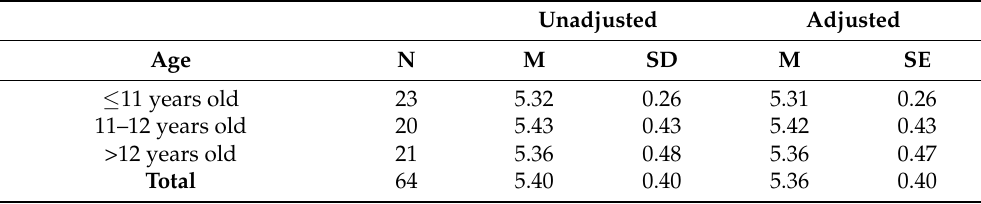
Table 3. Adjusted and unadjusted means for post-operative HbA1c.